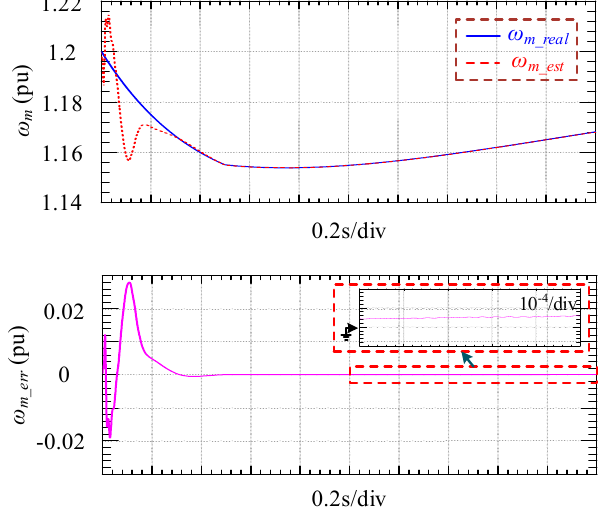
Figure 17. Real and estimated rotor speeds.